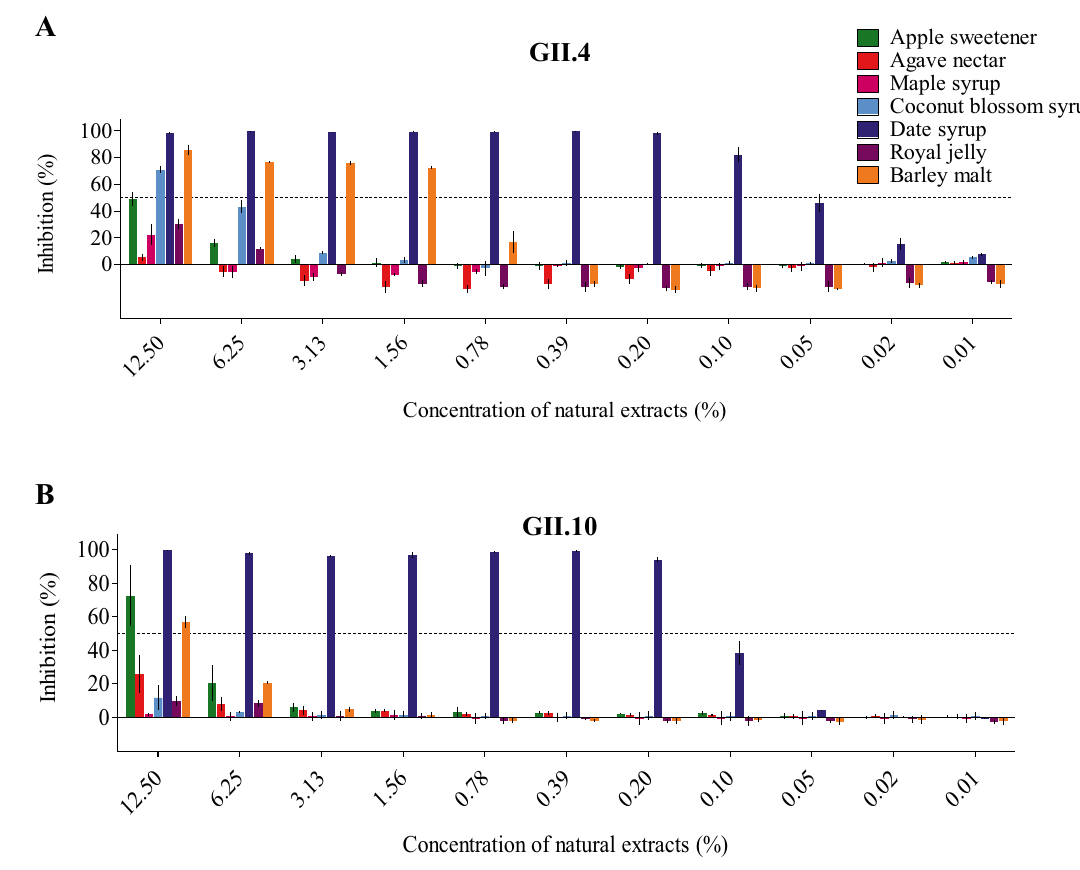
Figure 1. Natural extracts blocking GII.4 and GII.10 VLPs attachment to HBGAs. VLPs were mixed with serially diluted natural extracts and the HBGA attachment inhibition level was measured using ELISA. The final concentration of the natural extracts ranged between 12.5 and 0.01%. All experiments were performed in triplicates and the standard deviation is shown as error bars and the IC 50 cutoff is indicated by a dashed line. ( A ) For GII.4 VLPs, date syrup showed the strongest inhibition (IC 50 = 0.06%) followed by barley malt (IC 50 = 0.9%). All other natural extracts showed little blocking potential at the concentrations tested. ( B ) For GII.10 VLPs, date syrup inhibited binding to HBGAs at a low concentration (IC 50 = 0.11%), whereas other natural extracts were not effective at the concentrations